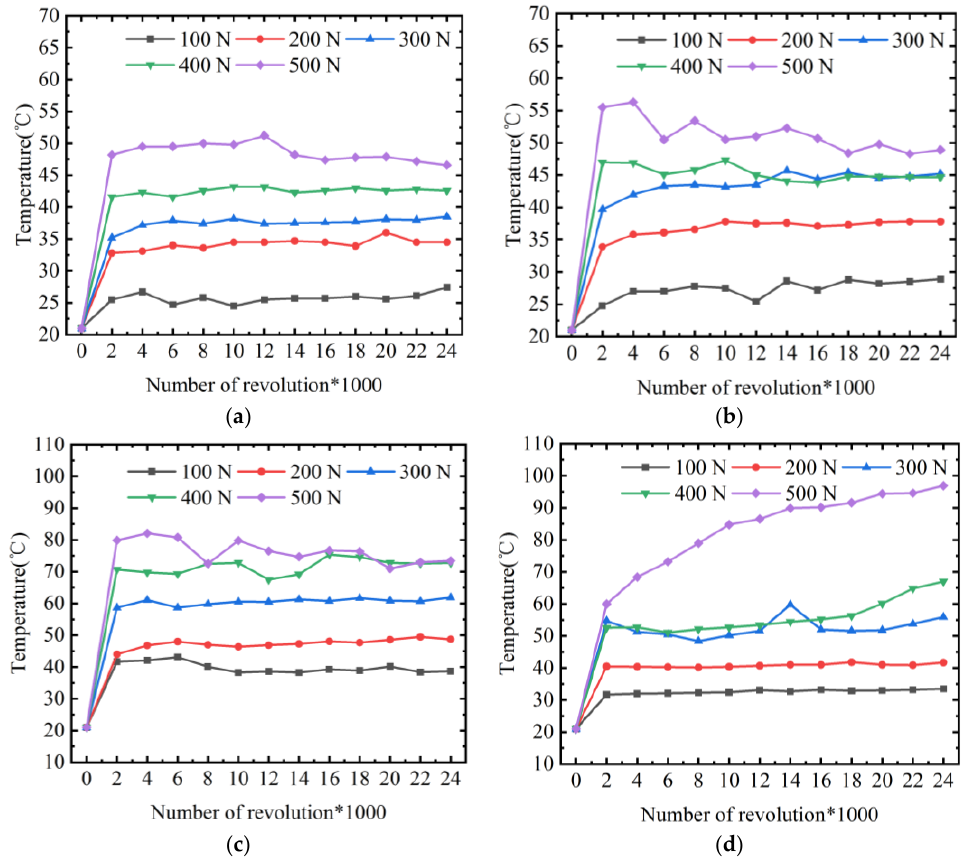
Figure 3. Friction temperature of four materials under different loads: ( a ) aluminum bronze; ( b ) aluminum bronze-based ISSLB material; ( c ) tin bronze; ( d ) tin bronze-based ISSLB material. (Note: * means